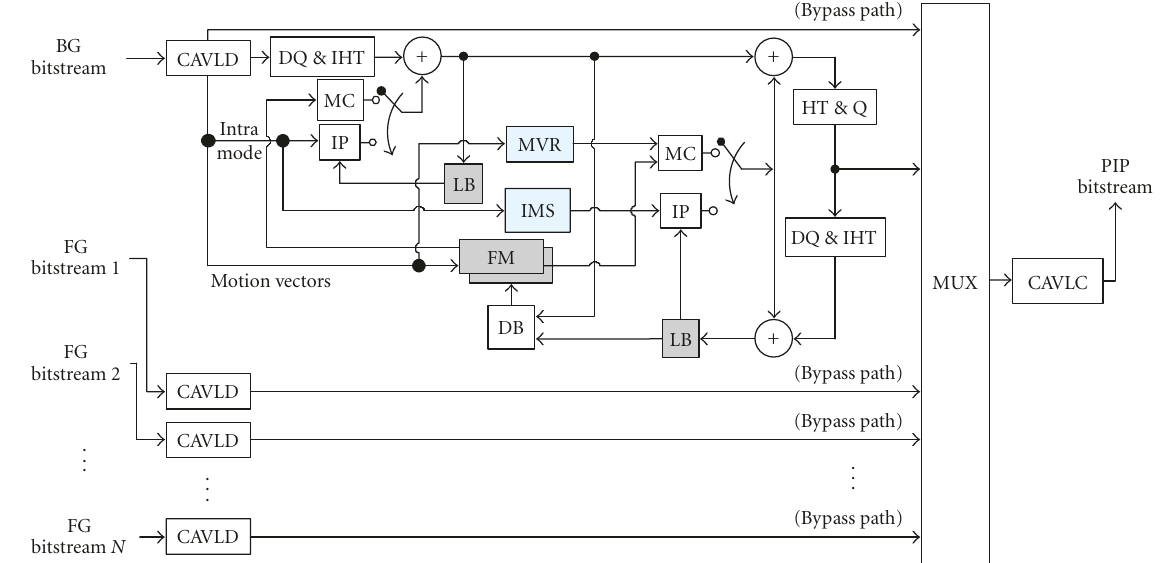
Figure 6: Final architecture of RFMT with shared frame memory for the constrained FG bitstreams.